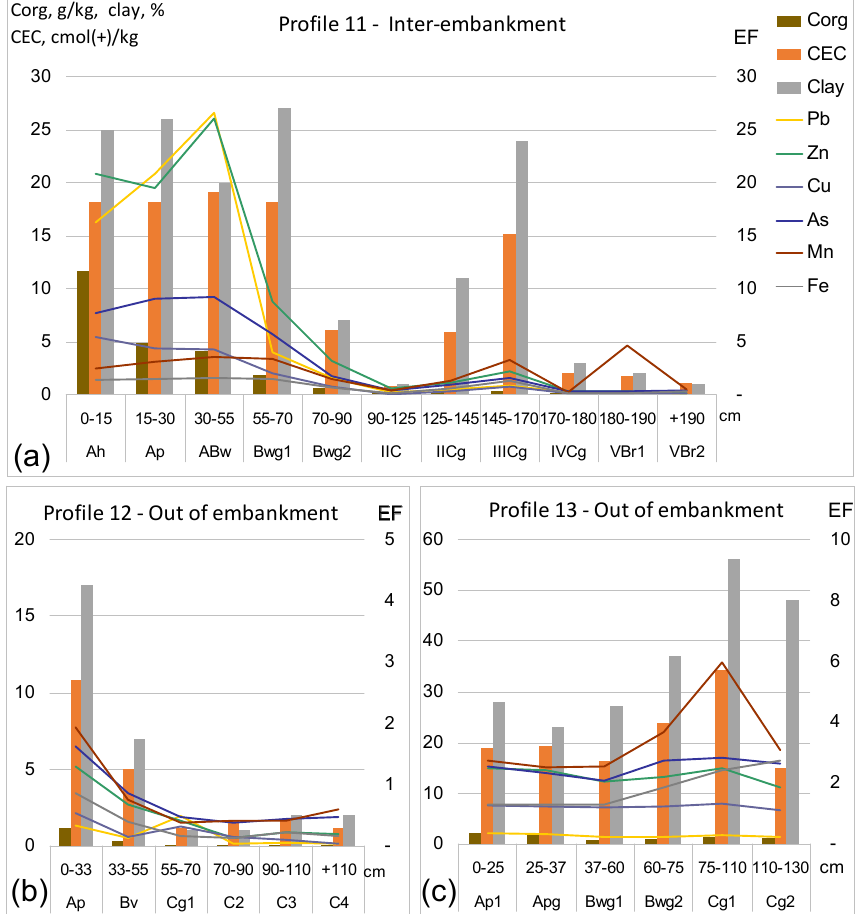
Figure 3. Distribution of metal(loid)s, against the background of crucial parameters of soil properties, in profiles 11 ( a ) in inter-embankment zone, 12 ( b ) and 13 ( c ) out of embankments, in transect No. III. Deeper soil layers in profile 12 had the light texture of sand, while those in profile 13 were much heavier, i.e., clay loam and clay. EF—enrichment factor calculated in relation to geochemical background; details are provided in the text. Table 3. Reference concentrations of metal(loid)s in soils according to various sources.